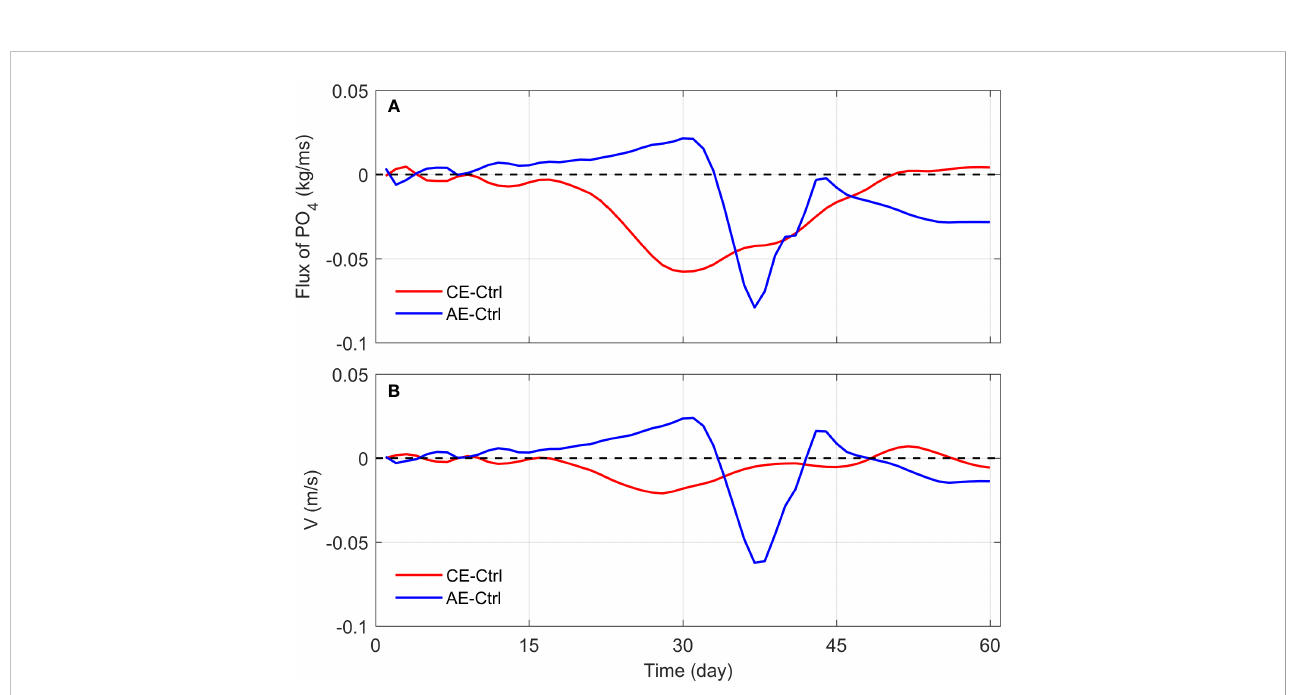
FIGURE 6 Time series of differences in volume-averaged cross-shelf (A) phosphate fl ux and (B) velocity west of 124.17°E between the eddy experiments and control run.